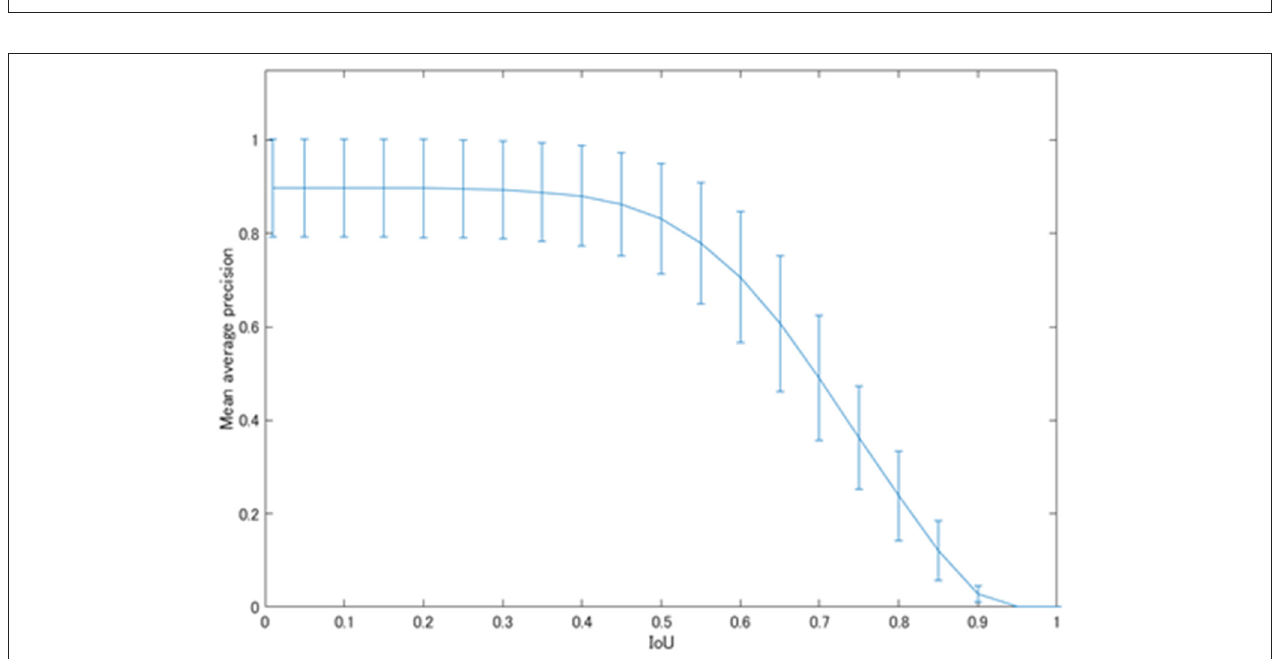
FIGURE 5 | The mAP values of the physiological